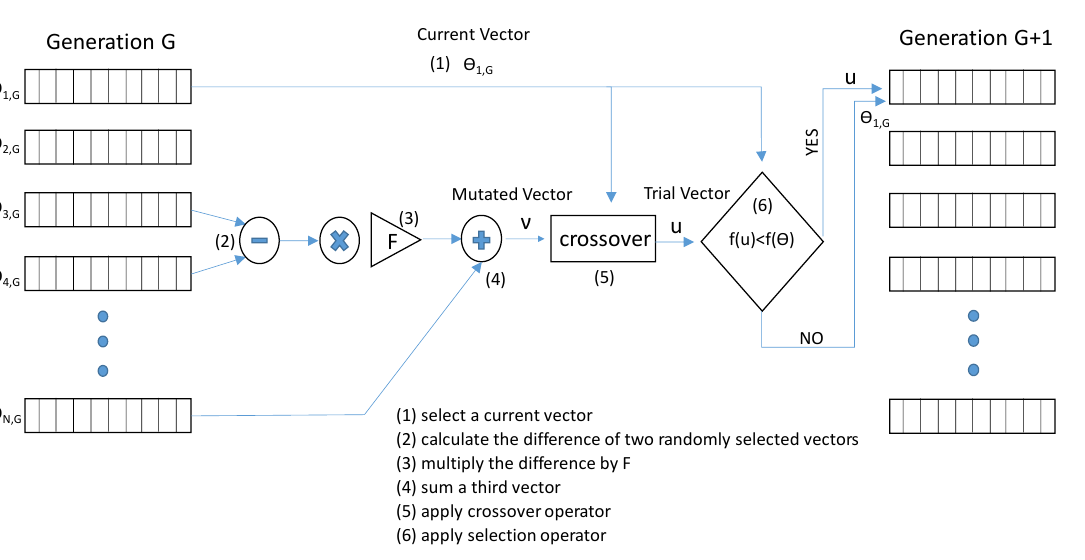
Figure 6. Differential Evolution Algorithm.